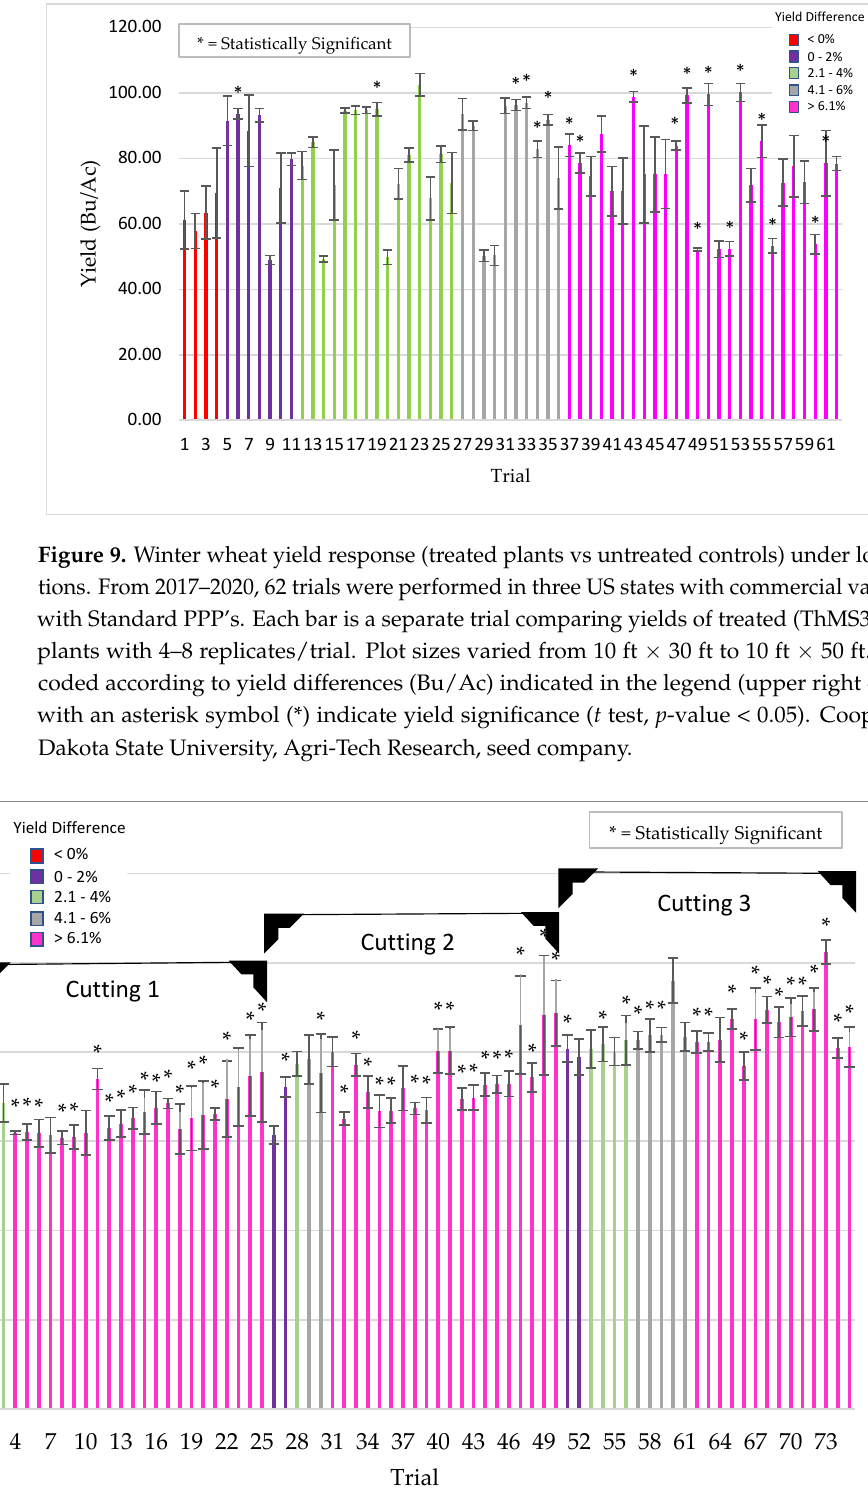
Figure 10. Alfalfa yield response of treated (ThMS3a) vs untreated controls plants under low stress conditions. From 2016–2020, 75 trials were performed in four US states (WI, SD, NV, AZ) on commercial varieties with standard PPP’s. Each bar is a separate trial and plots sizes varied from 10 ft × 50 ft to 10 acres with 4–8 replications/trial. In each trial, there were three successive cuttings every 1 – 1.5 months and is indicated as the average yield (lbs/acre). Bars are color coded according to yield differences indicated in the legend (upper left of graph). Bars with an asterisk symbol (*) indicate yield significance ( t test, p -value < 0.05). Cooperators: farmers, CRO ’ s, universities.